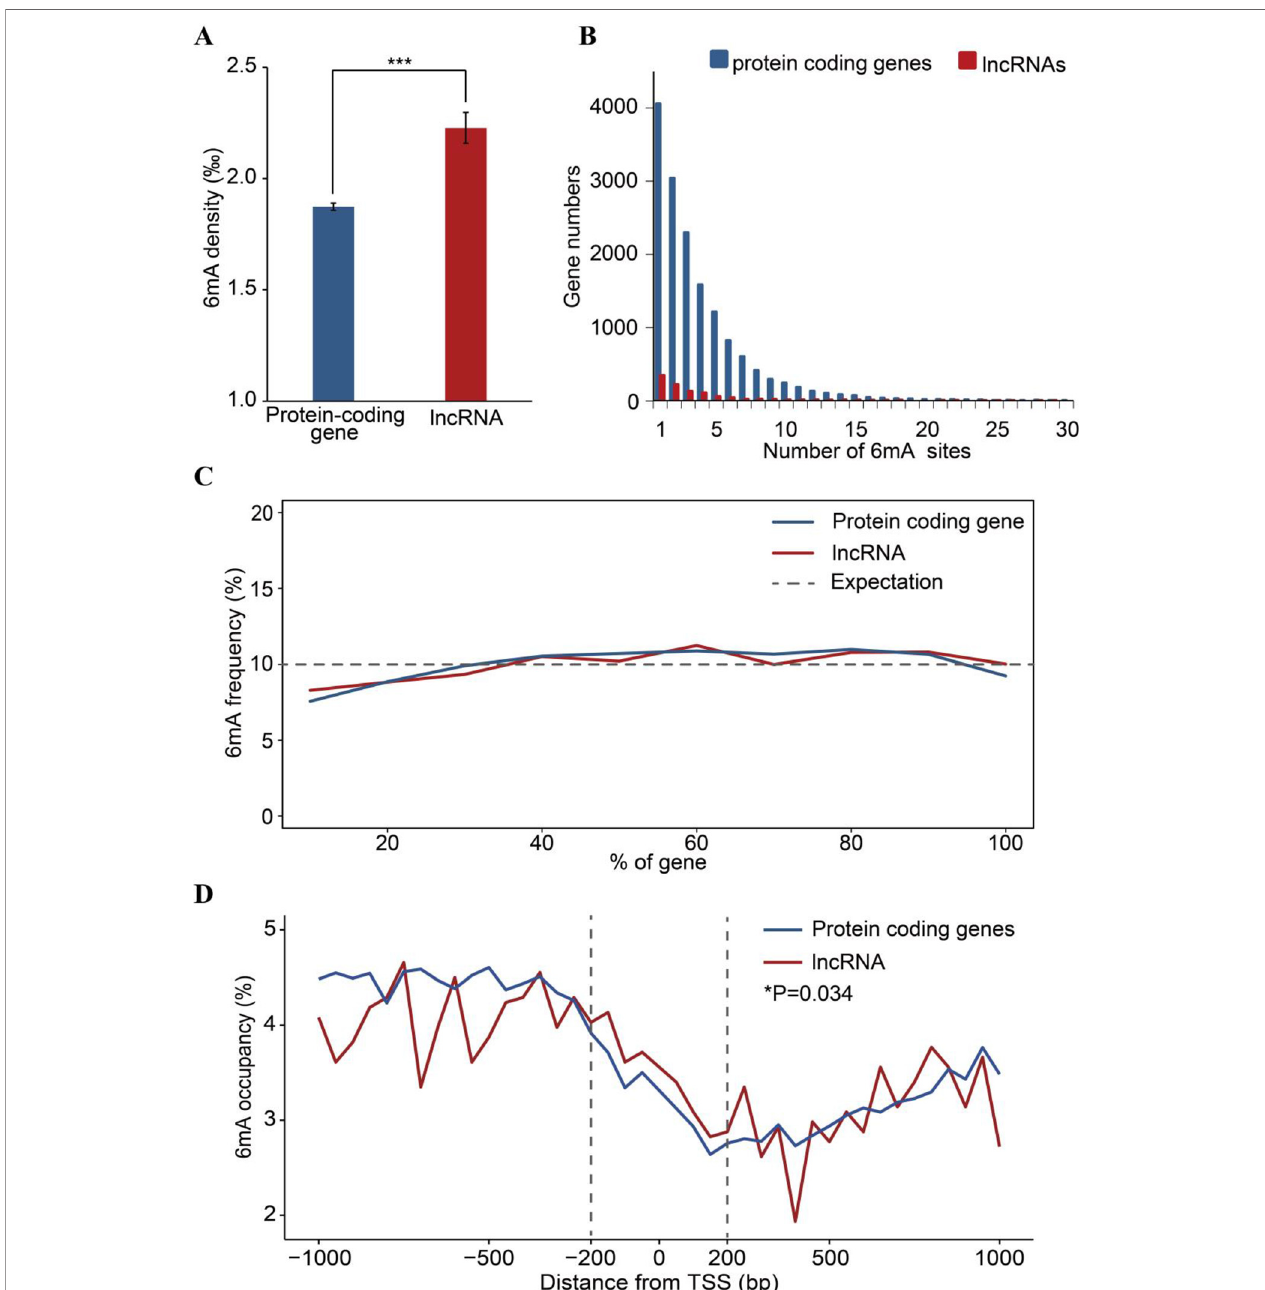
FIGURE 5 | Comparisonof6mA methylation in longnon-coding(lnc)RNA andprotein-codinggenes. (A) Different 6mAmodi fi cation densities inlncRNA and protein-coding genes (*** p < 0.001, Student ’ s t test). (B) Statistics of gene numberswith different 6mAsites between lncRNA andproteincodinggenes. (C) Frequency of 6mAsites at relative positionsinlncRNA and protein-coding genes. (D) Distribution of 6mA occupancy around the transcription start site ( TSS ) oflncRNA andprotein-coding genes (6mA occupancy represents the relativenumber of methylatedgenes against the total number ofprotein-coding or lncRNA genes ineach 50-bp window plotted within a 1-kb region upstream and downstream ofthe TSS). The 200-bp regionsupstream and downstream of the TSS are marked by dashed lines (* p < 0.05, Student ’ s t